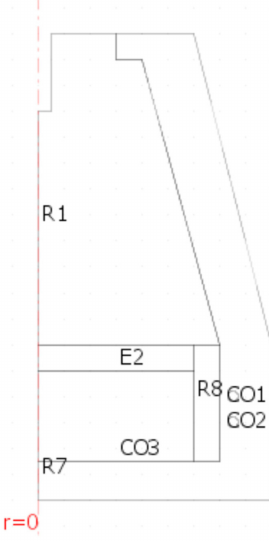
Figure 1. 2D model geometry of the induction + microwave heating of the load. Table 1. Subdomain description referred to Figure 1 and relevant properties used in the model: relative permittivity, electrical conductivity, density, thermal conductivity and specific heat. The outer space is assumed to be a Perfect Electric Conductor (PEC). Relative permeability is set at 1.